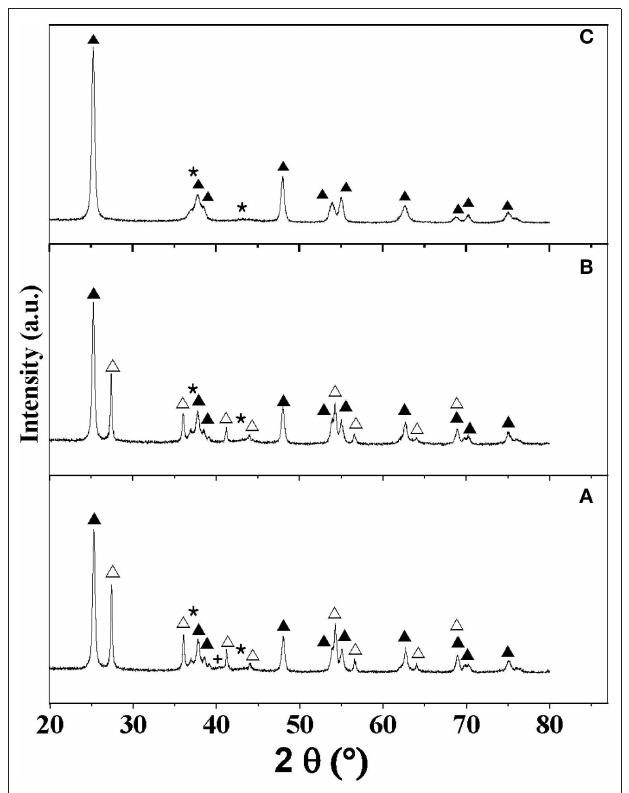
FIGURE 5 | Temporal evolution of CO 2 conversion and selectivity of products during the hydrogenation of CO 2 over 400mg of MoC/TiO 2 -P at 250 ◦ C and 2 :CO 2 ratio of 5:1, 150min on stream after stabilization of the temperature.